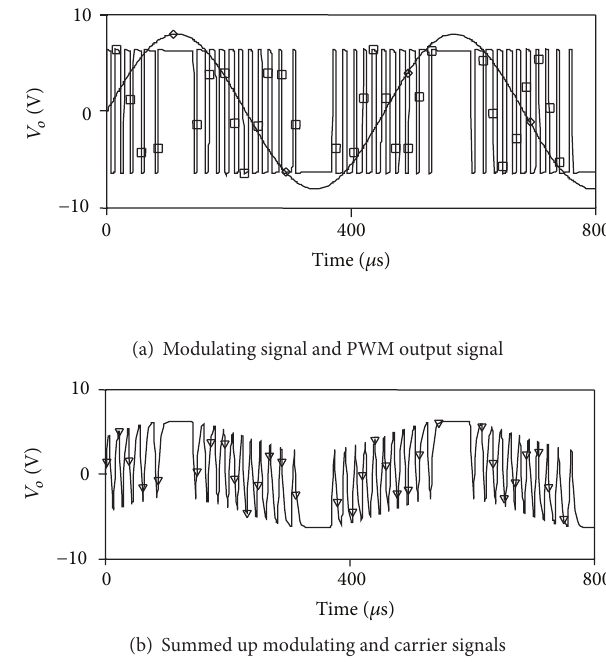
(b) Summed up modulating and carrier signals F 9: PWM output of for 8V, 2.2KHz modulating